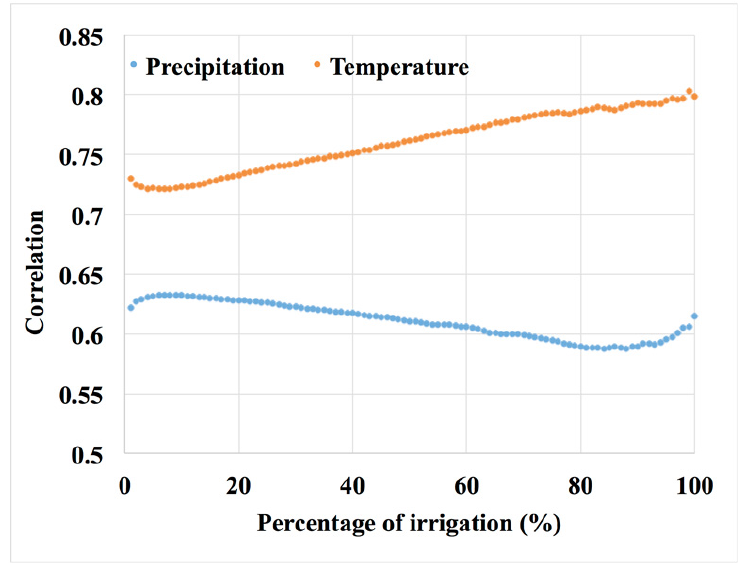
Figure 12. Relationship of temperature and precipitation correlation to percent area equipped for irrigation in five-arc minute pixels